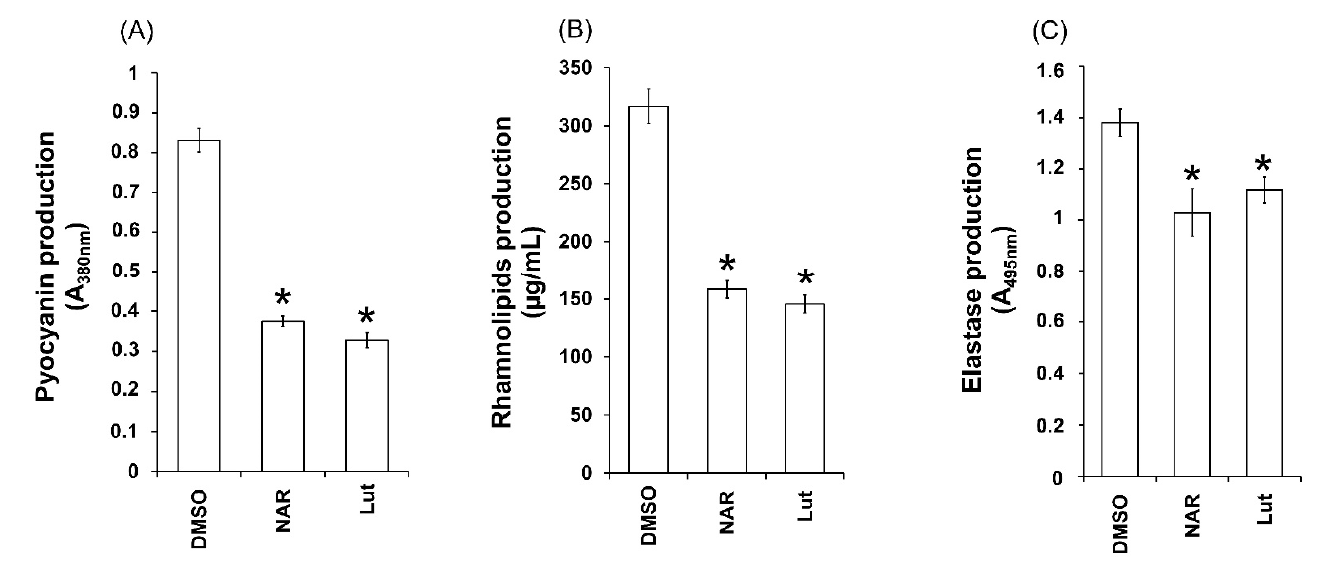
Figure 7. Lut inhibits the PAO1 production of virulence factors: ( A ) Effects of Lut on pyocyanin production; ( B ) Effect of Lut on rhamnolipids production; ( C ) Effect of Lut on elastase production. Lut was tested at 22 µM; naringenin (NAR; 4 mM) and dimethylsulfoxide (DMSO, 1%) are used as positive and solvent control, respectively [27]. Pyocyanin was extracted and quantified by absorbance measurement at 380 nm. The rhamnolipids production was measured using methylene-blue-based method and expressed in µg/mL. Elastase production was assessed by an elastolysis assay and calculated as the ratio between A 495 and A 600 . All experiments were performed in triplicate with three independent assays. Error bars represent the standard error of the mean and the asterisks indicate samples that are significantly different from control condition ( p ≤ 0.01).